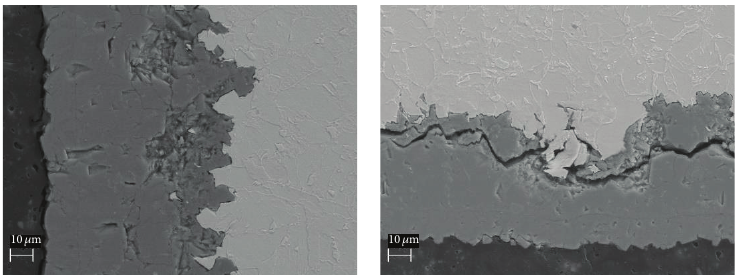
Figure 6: Scale morphology on B-N specimens.